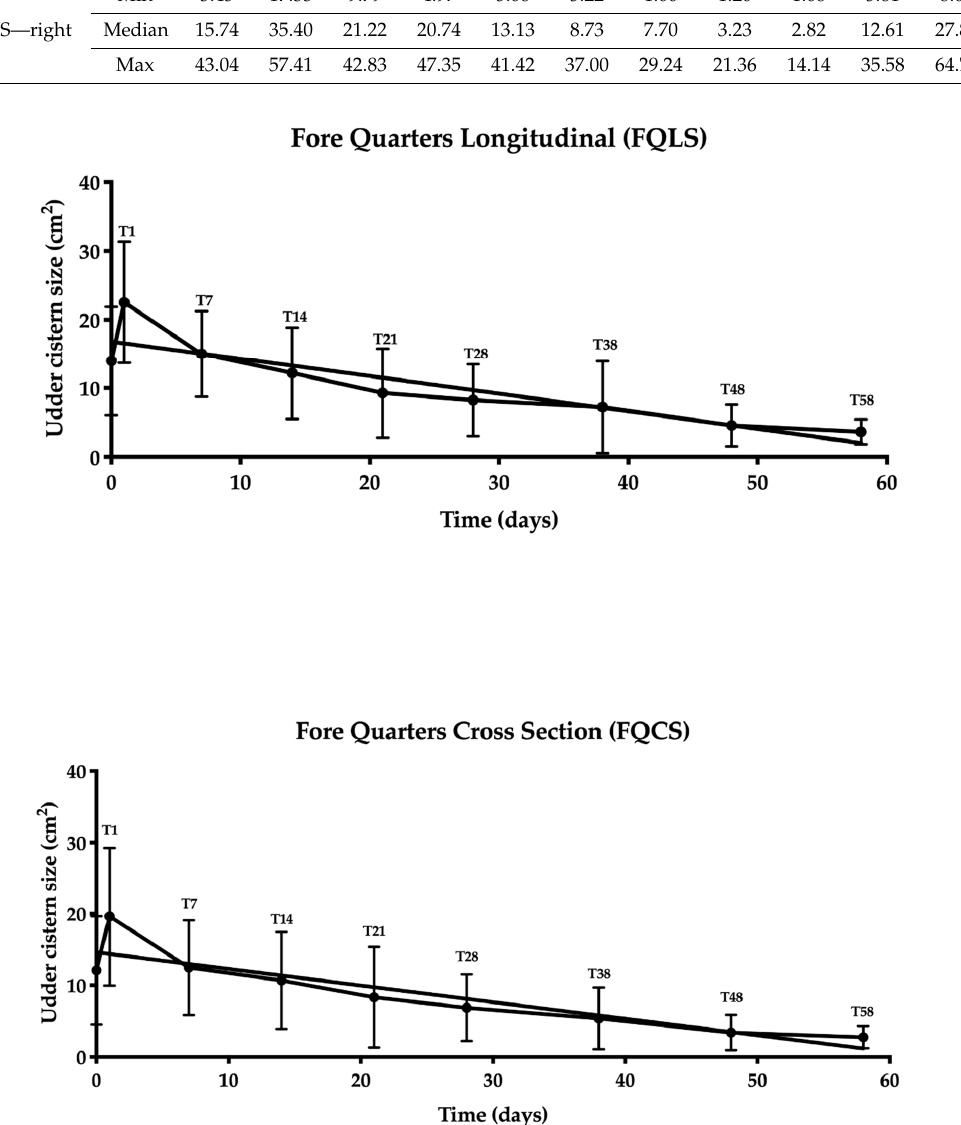
Figure 2. Correlation analysis between the udder cistern size and time (T0–T58) for front quarters in the longitudinal and cross